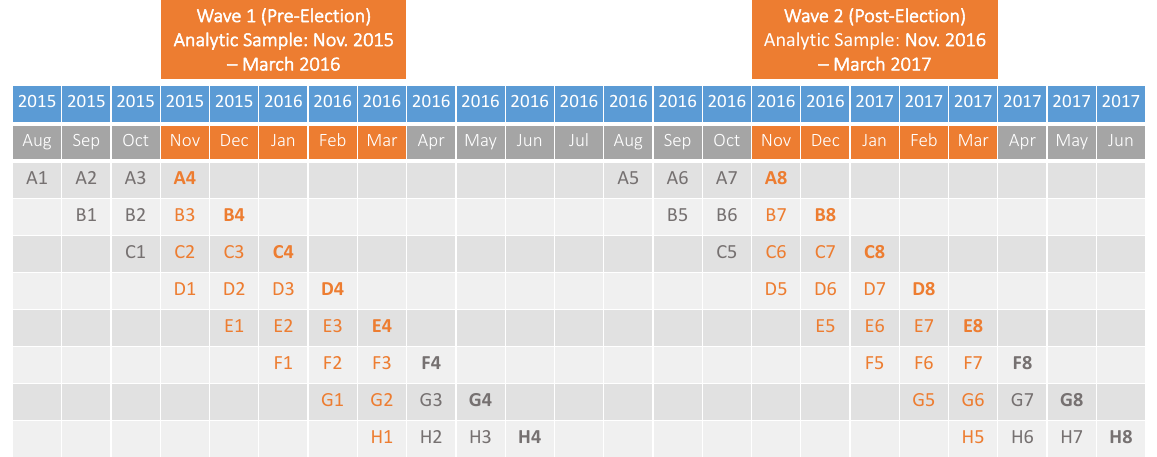
Figure 1: Structure of CPS panel data samples used in analysis of year-over-year change in weekly work hours. Notes: The table cells denote distinct CPS survey cohort groups (letter) and month in sample (number). The CPS uses a rotating sample design, whereby respondents in each cohort are observed for four months, dropped for eight months, and then observed again for four months. A new cohort is added to the survey in every calendar month. Workers’ hourly paid status is only asked during months 4 and 8 (denoted in bold font), but additional observations can be backwardly linked for those hourly workers who report remaining in the same job as the prior monthly survey. This produces up to four year-over-year spans per respondent (e.g., D1 to D5, D2 to D6, D3 to D7, D4 to D8). Our main analyses are restricted to the range of monthly observations highlighted in